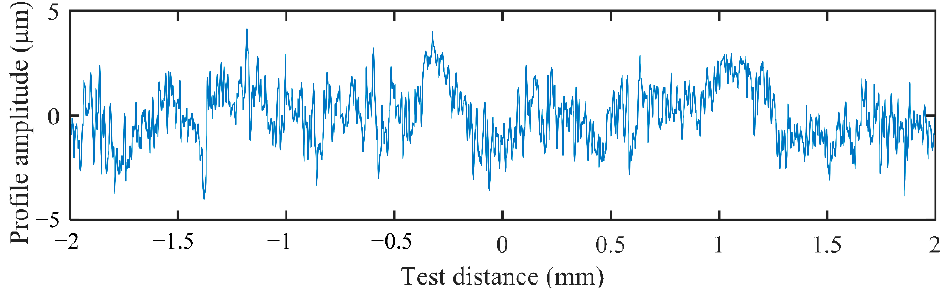
Figure 2. Topography of tested gear surface.